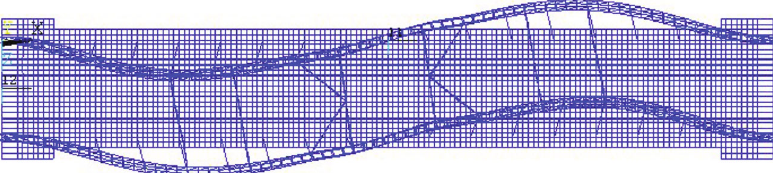
Figure 23: The second order buckling mode of arch bridge under case